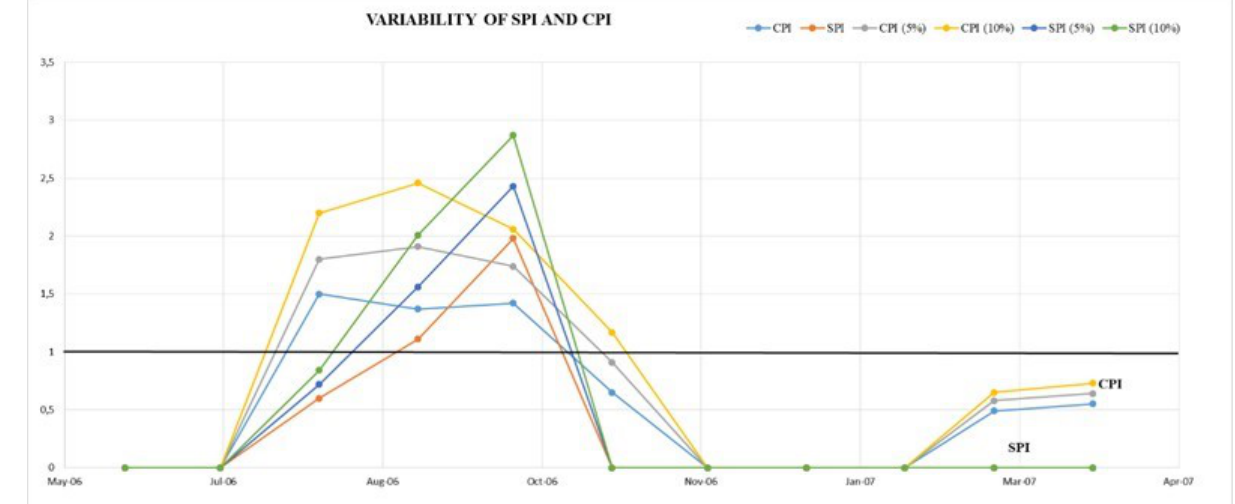
ties for failure to comply with the work schedule (0.3% of the contract value for each day of delay) and a fine for with- drawal from the contract (10% of the contract price). Unfor- tunately, in both cases, the initially-selected subcontractor resigned and left the site mainly due to financial